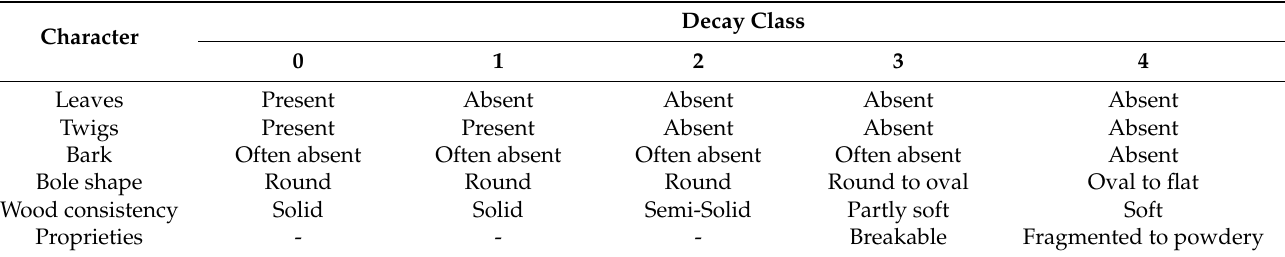
Table 1. Qualitative classification system of decay